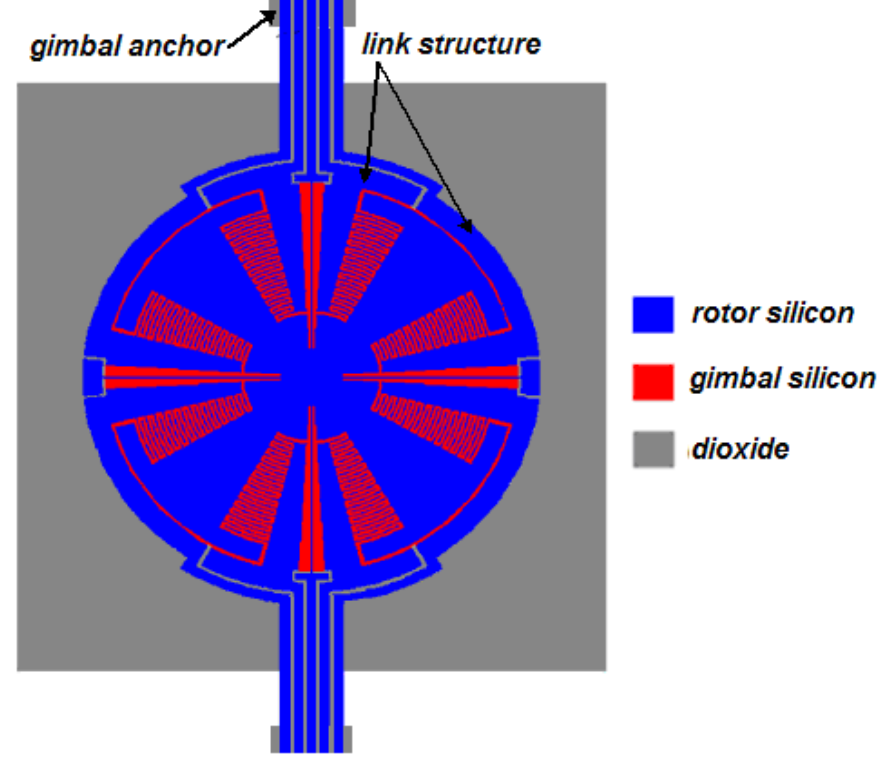
Figure 3. The designed link structure to supply electronic